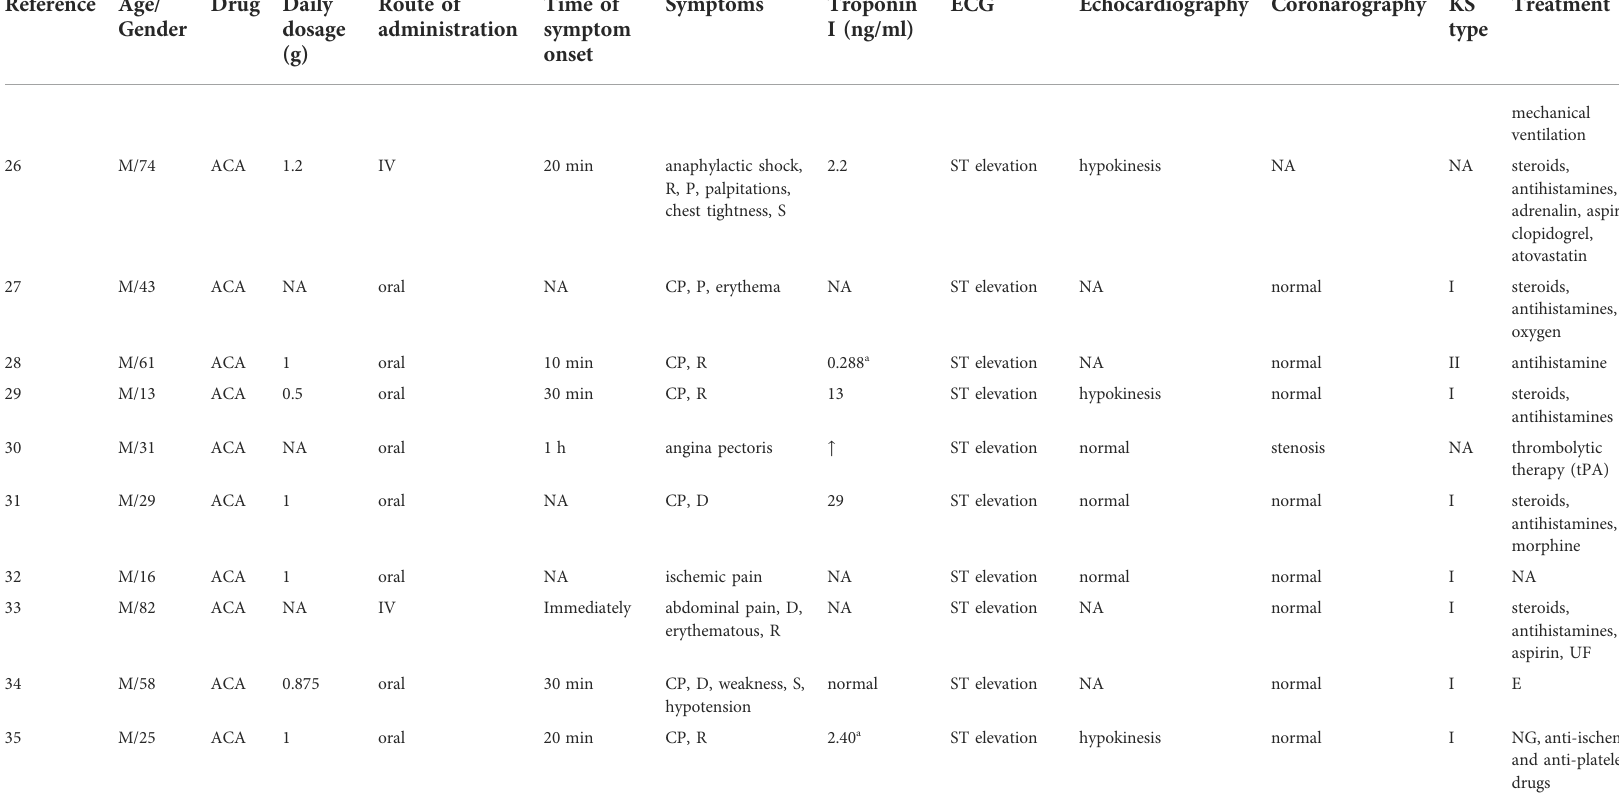
TABLE 1 ( Continued ) Summary of clinical information of 33 patients with amoxicillin-induced Kounis